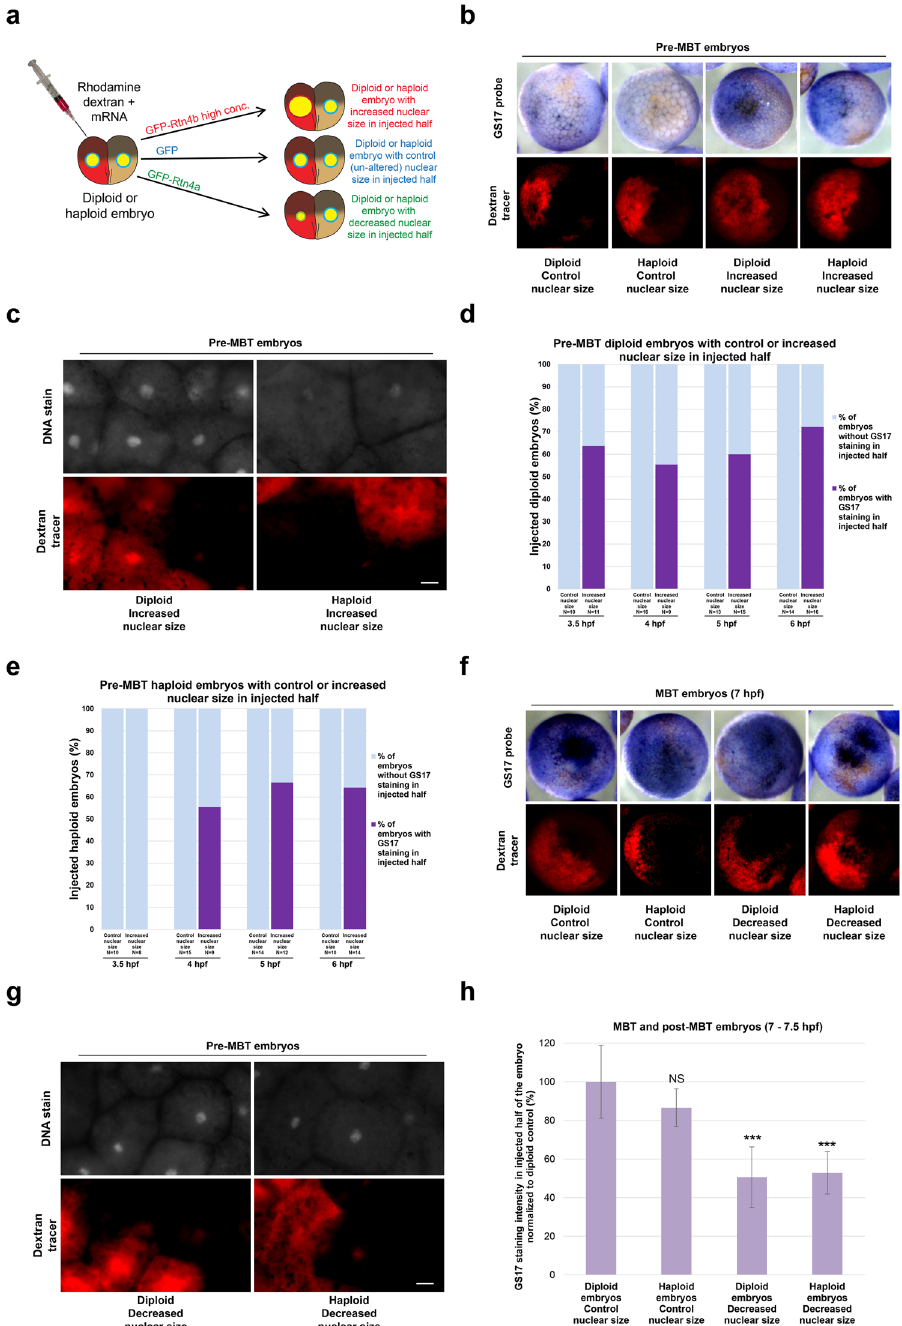
Figure 2. GS17 in situ hybridization in embryos with altered nuclear size and ploidy (a) One blastomere of a two-cell haploid or diploid embryo was coinjected with rhodamine-labeled dextran as a tracer and mRNA to alter nuclear size in half of the embryo. For control embryos, 3.5, 4, 5, 6, and 7 hpf correlate to stage 6, 6.5, 7, early 8, and 8, respectively. (b) GS17 in situ hybridization was performed on pre-MBT embryos with increased nuclear size in half of the embryo. Bright-field images of embryos stained for GS17 (purple) are shown in the top panels. The corresponding rhodamine (red) fluorescence images indicating cells in the embryo that received the microinjected mRNA are shown in the bottom panels. Representative embryos are shown. (c) 5 hpf diploid and haploid embryos with increased nuclear size in the injected halves were stained with Sytox Green and cleared for imaging. The top panels are fluorescent images of embryos stained for DNA. The bottom panels are the corresponding rhodamine fluorescence images indicating cells in the embryo that received the microinjected mRNA. Representative embryos are shown. Scale bar, 20 µ m. (d,e) The graphs show the percentage of pre- MBT diploid (d) and haploid (e) embryos with (dark purple) or without (light blue) differential GS17 staining. Embryos were scored as showing differential GS17 staining as long as some cells that received the microinjected mRNA stained positively for GS17. N = number of embryos. (f) 7 hpf embryos with decreased nuclear size